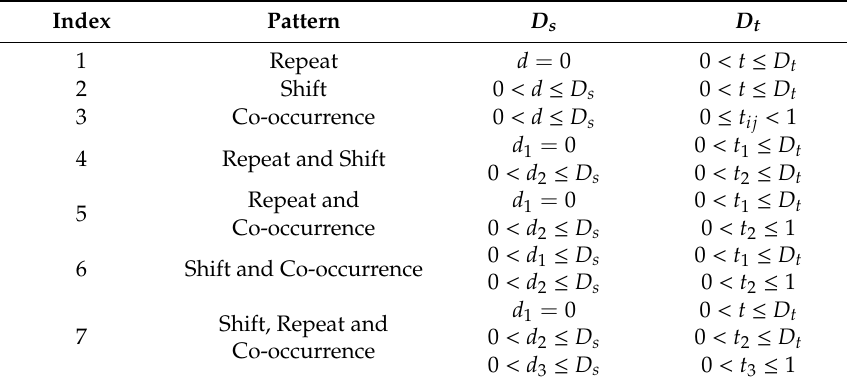
Table 1. Rules for the construction of crime network.